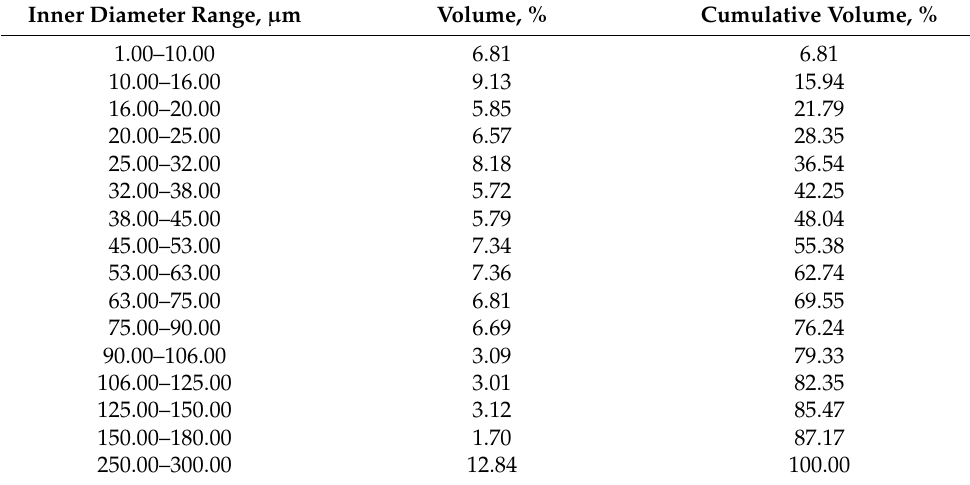
Table 7. Granulometry of tin oxide powder.